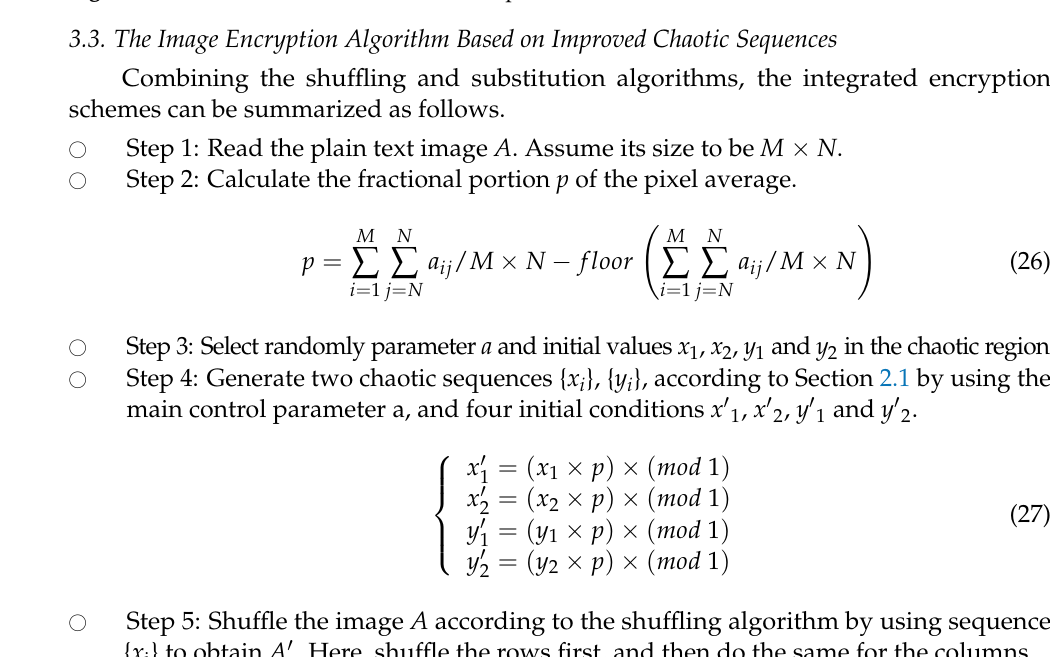
Figure 11. The flowchart of the substitution